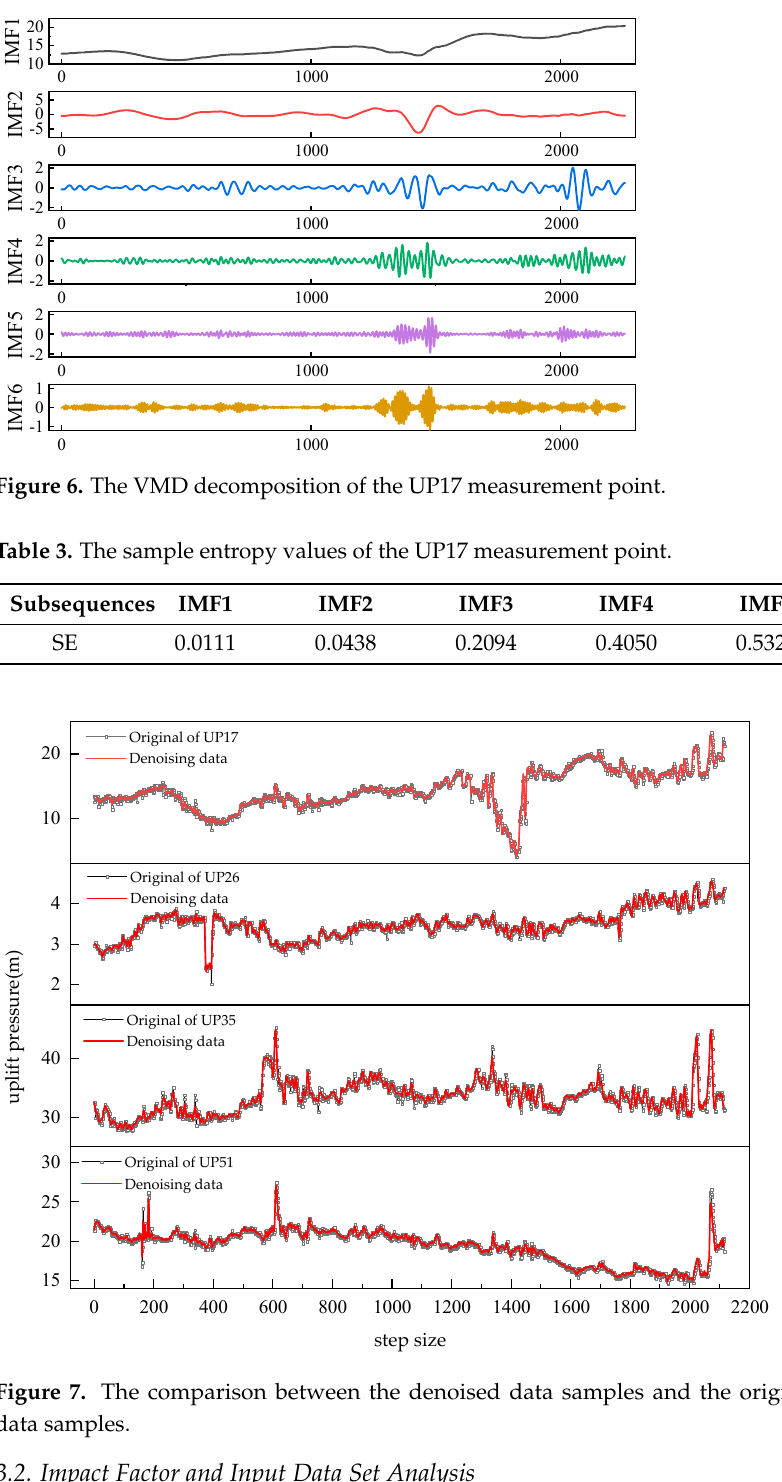
Table 3. The sample entropy values of the UP17 measurement point.